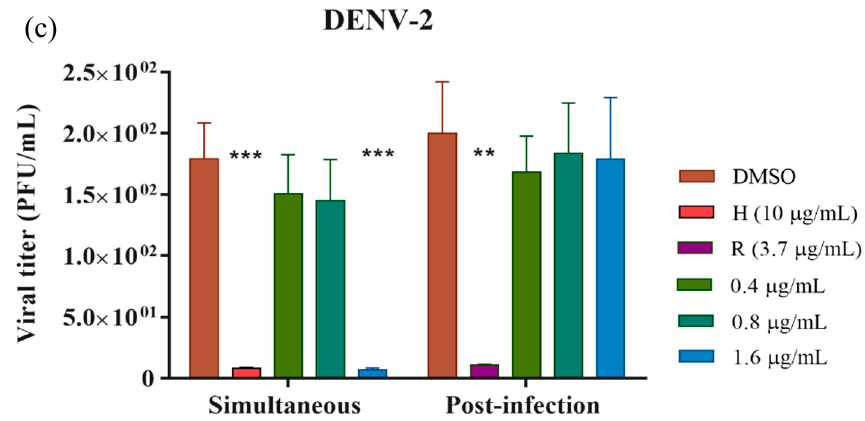
Figure 2. Effect of NQ 4 on the viral titer reduction of HHV-1, HHV-2 and DENV-2 in simultaneous and post-infection treatments. Vero or BHK-21 cells were infected with HHV-1 ( a ), HHV-2 ( b ) and DENV-2 ( c ) and treated with several concentrations of NQ 4 at different stages of the viral replicative cycle. Virions were quantified by plaque forming unit (PFU) titration (PFU/mL). Bars represent the mean ± SEM relative to DMSO control from two independent experiments. p values were determined by unpaired Student’s T-test (***, p < 0.001; **, p < 0.01). DMSO: dimethyl sulfoxide; DS: dextran sulfate (5 µg/mL); A: acyclovir, (1.5 µg/mL); H: heparin (10 µg/mL); R: ribavirin (3.7 µg/mL); NQ 4 against